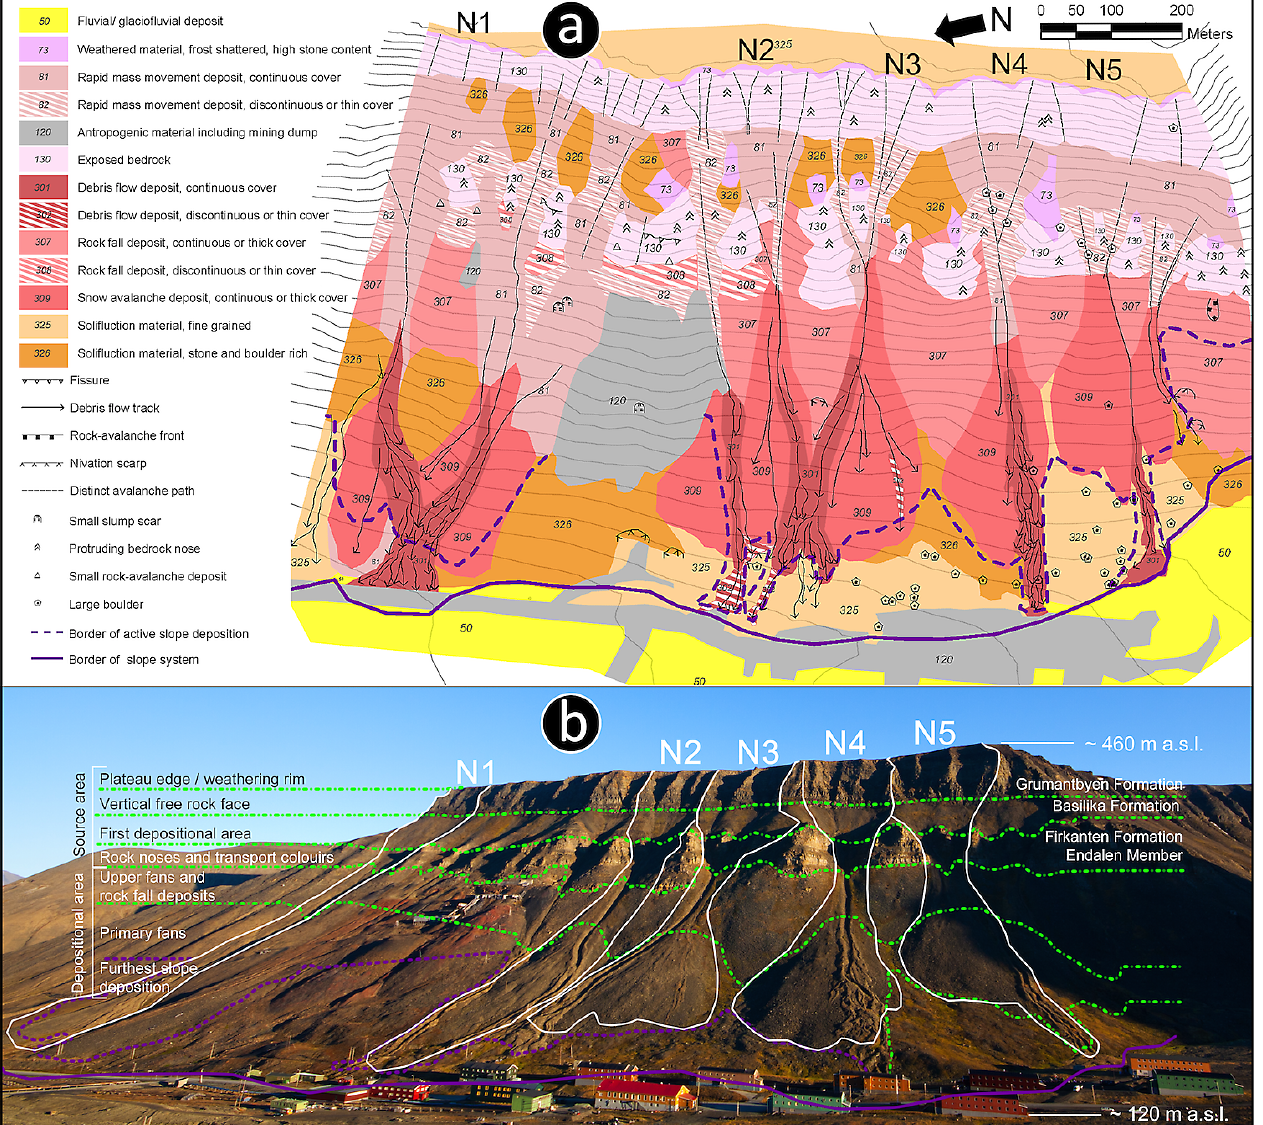
Fig. 3. (a) Geomorphology and sediments of the Nybyen slope system based on detailed geomorphological field mapping and 3-D aerial photogrammetry. (b) Nybyen with the five investigated catchments (N1–N5) (white line). The white line indicates the observed maximum modern runout distance of cornice fall avalanche sedimentation. The green dashed lines indicate different parts of the source and depositional areas or delimit the geological formations. The debris flow channels located in the overall depositional area are, however, erosional features. The purple line indicates the maximum extent of the slope deposits. Therefore, some of the infrastructure is built on slope